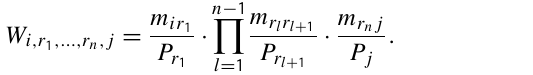
Fig. B2: Different CMR pathways from grid cell 1 to grid cell 4 . The contribution of the direct pathway is W 1 , 4 = m 14 /P 4 , the contribution of the path involving one re-evaporation cycle in grid cell 3 is W 1 , 3 , 4 = m 13 /P 3 of the path involving re-evaporation cycles in grid cells 2 and 3 is W 1 , 2 , 3 , 4 = m 12 /P 2 same that in Fig. 3.